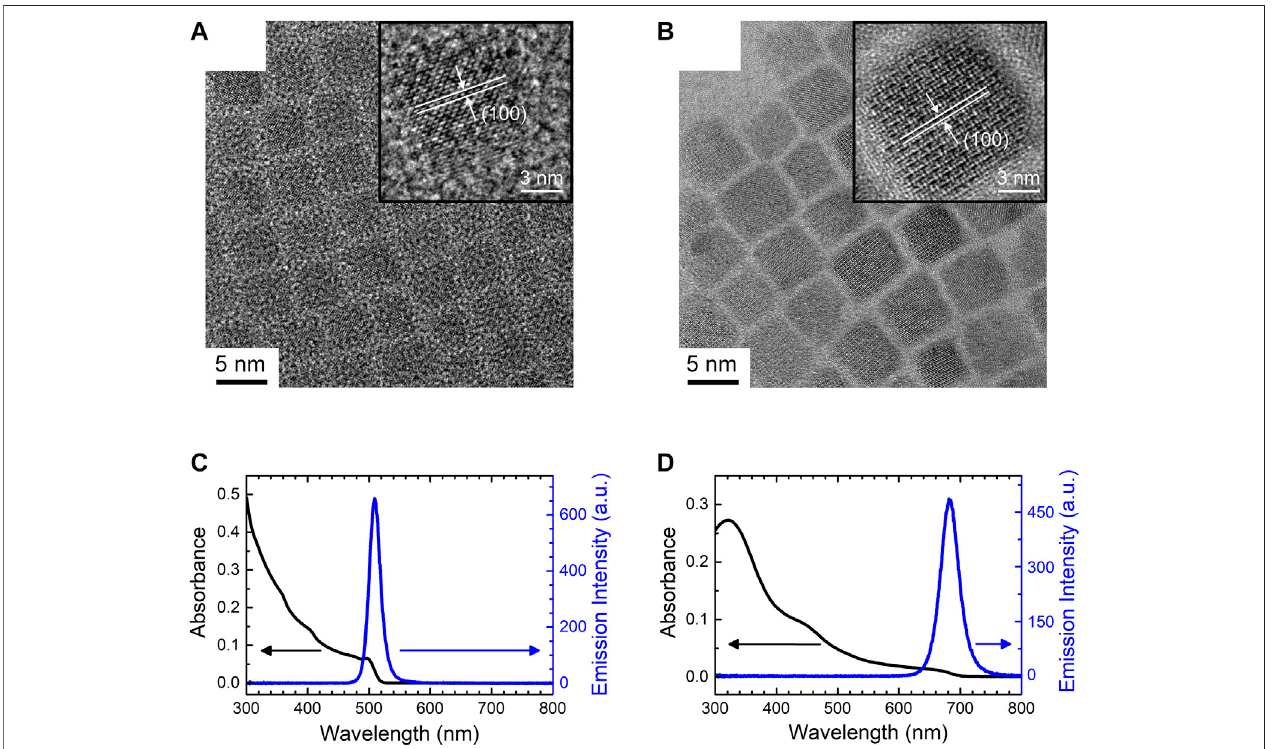
FIGURE 1 | TEM images of (A) CsPbBr 3 and (B) CsPbI 3 PQDs. The insets show enlarged views of individual PQDs. UV-Vis absorption and PL spectra of (C) CsPbBr 3 and (D) CsPbI 3 colloidal PQD